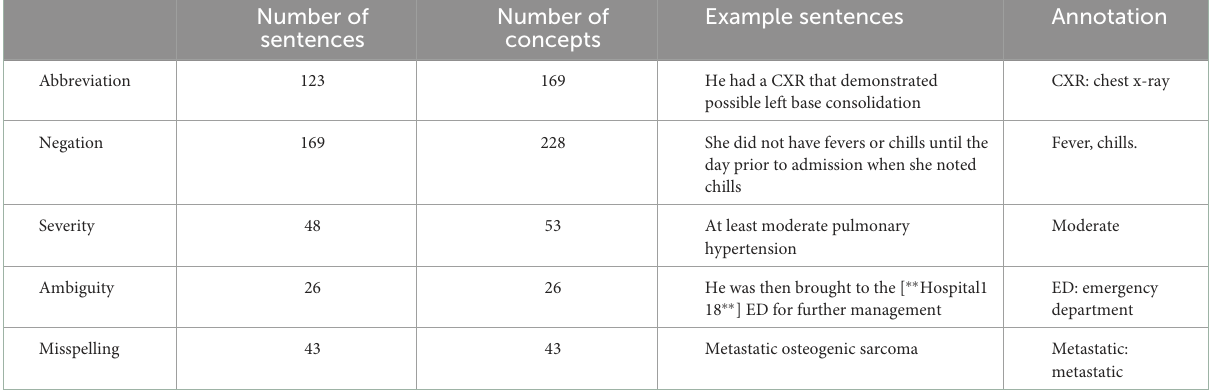
TABLE 2 Details and examples of sentences annotated in the MIMIC-III